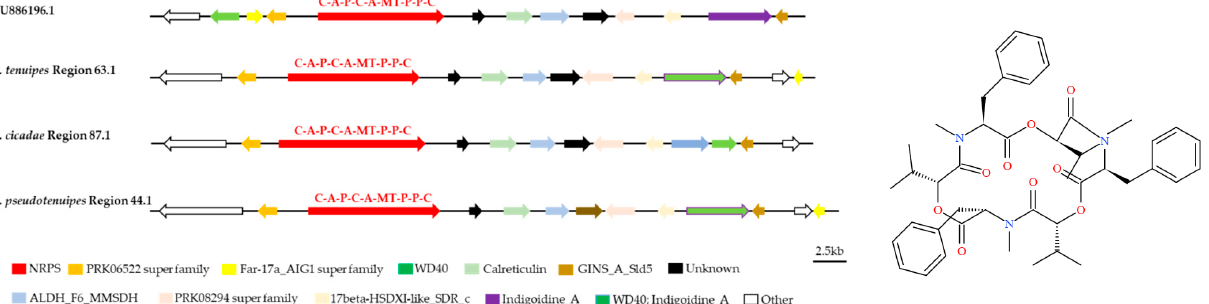
Figure 7. Comparison of putative beauvericin biosynthetic gene clusters and structure. The number after the region and the number before the decimal point represent the scaffold, and the number after the decimal point represents the gene cluster.